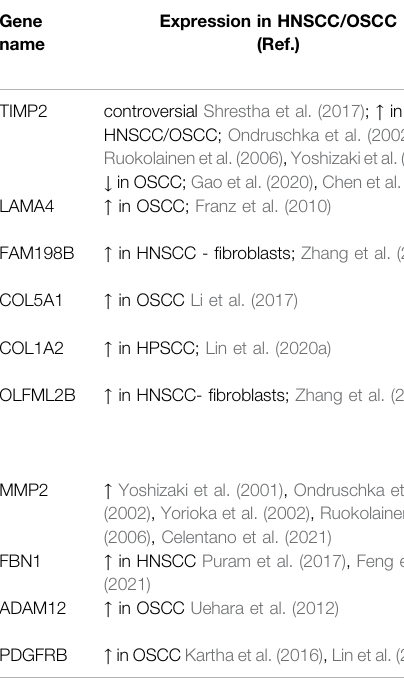
TABLE 1 | Expression and epigenetic regulation of PNI-HNSCC signature